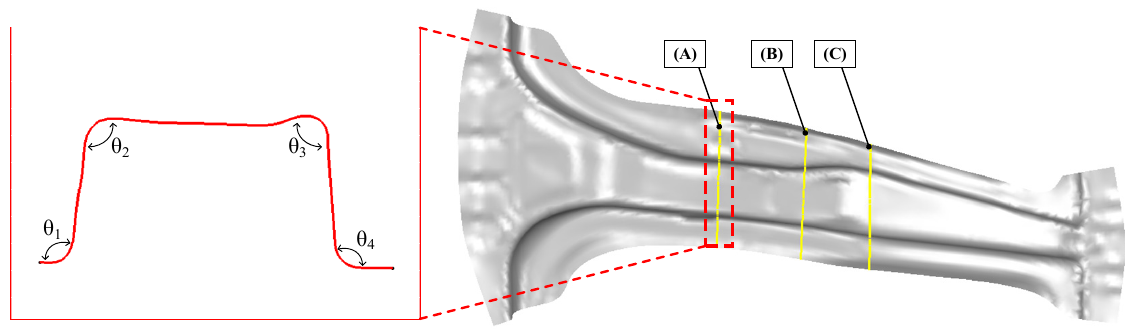
Figure 5. Measuring sections of the B-pillar for the evaluation of the spring-back behavior. Figure 6 shows a comparison of the spring-back between the FE simulation and the target angle. In the cross-section at A, the angles θ 1 , θ 2 , θ 3 , and θ 4 from the FE model were observed to be 142 ◦ , 97 ◦ , 92 ◦ , and 103 ◦ , respectively. The angles of the original model at the same position were measured as 138 ◦ , 93 ◦ , 91 ◦ , and 100 ◦ , respectively. The comparison showed that the B-pillar exhibited high dimensional accuracy in the case of sections (B) and (C). Therefore, the designed B-pillar can be used as a tool for the PCM process.